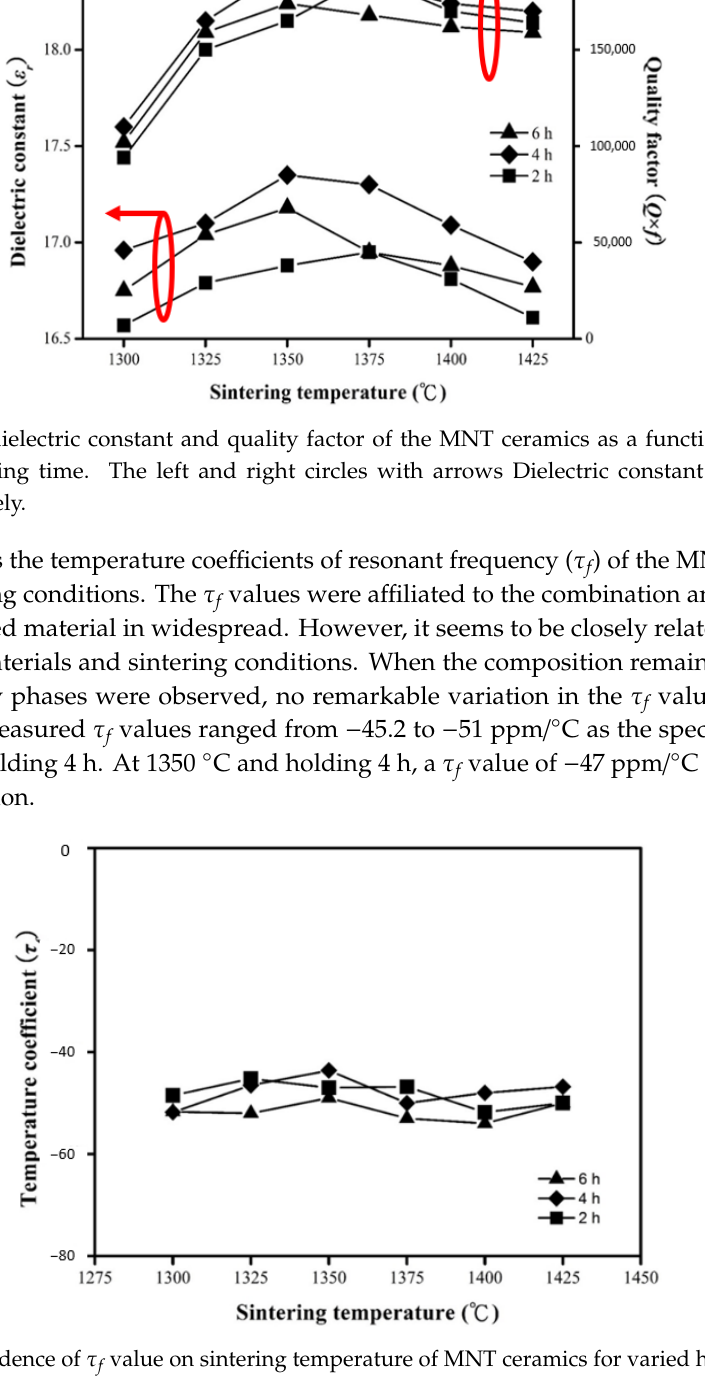
Figure 6. The dielectric constant and quality factor of the MNT ceramics as a function of the S.T. for varied holding time. The left and right circles with arrows Dielectric constant and Quality factor, respectively.